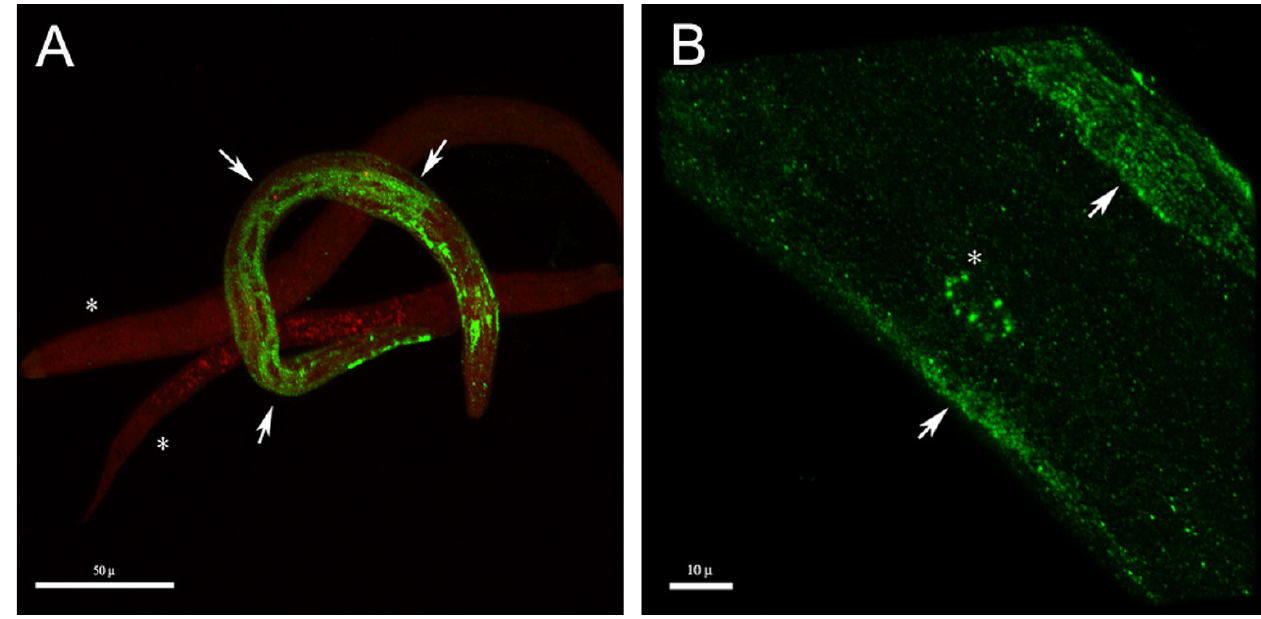
Figure 5 Immunofluorescence detection of GANA-1::GFP. A) A coarsely granular cytoplasmic distribution of immunopositivity (green) in body-wall muscle cells (arrowheads). Two non-transgenic worms are shown in the background (asterisks) for com- parison. Nuclei are counterstained in red. B) Detailed view of two body wall muscle cells with coarsely granular cytoplasmic distribution of immunopositivity (arrowheads) and a coelomocyte (asterisk), both pictures were acquired by 3D rendering of initial confocal Z-stacks. Note: compare with figure